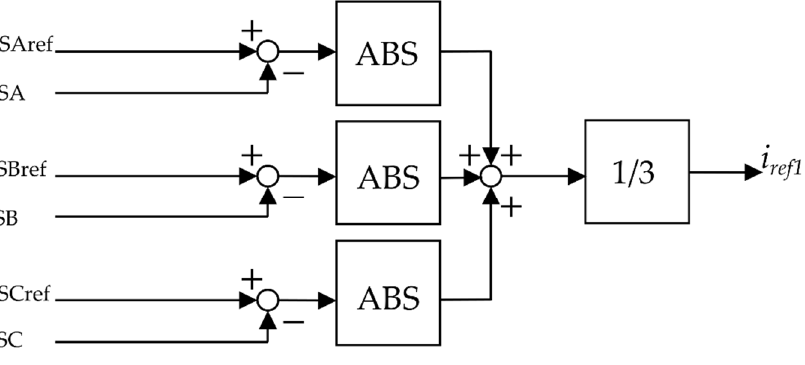
Figure 13. Block diagram of the algorithm determining the shape of the reference signal of the CM 2 supporting system.